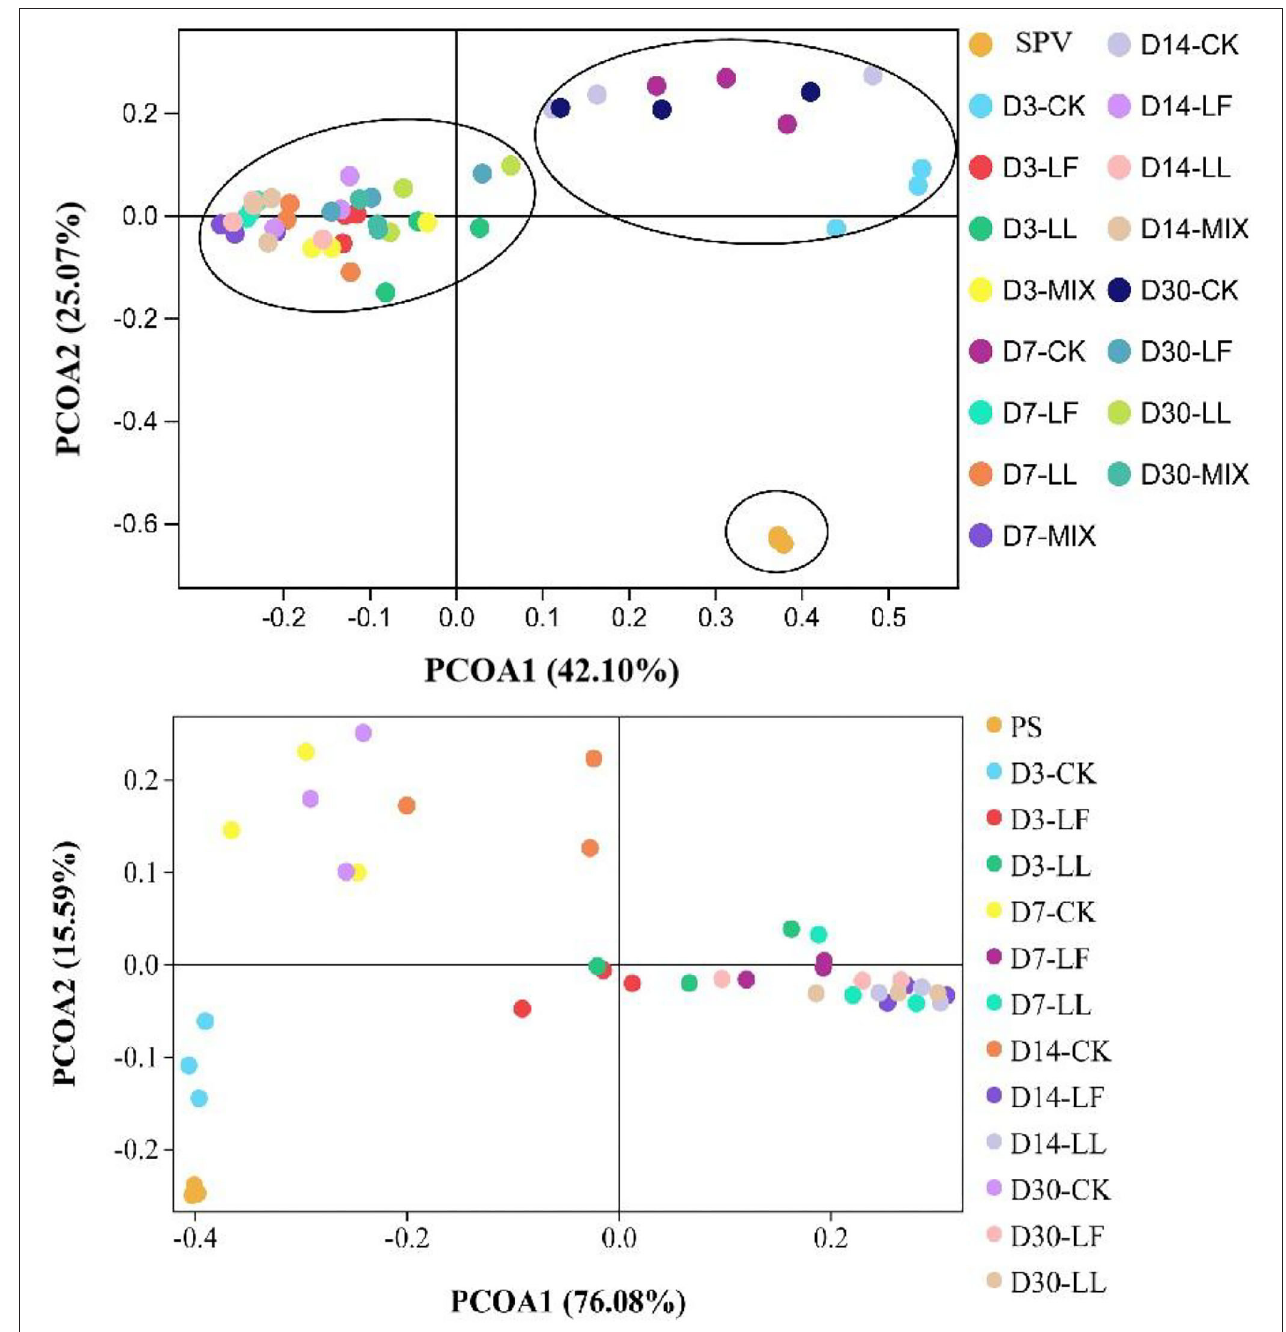
FIGURE 1 | Principal coordinate analysis (PCoA) of the bacterial community of inoculated or non-inoculated SPV and PS silage. SPV, sweet potato vine; PS, peanut straw; CK, non-inoculated silage (Control); LL, silage inoculated with Lactococcus lactis (LL); LF, silage inoculated with Lactobacillus farciminis (LF); MIX, silage inoculated with the mixture (1:1) of LL and